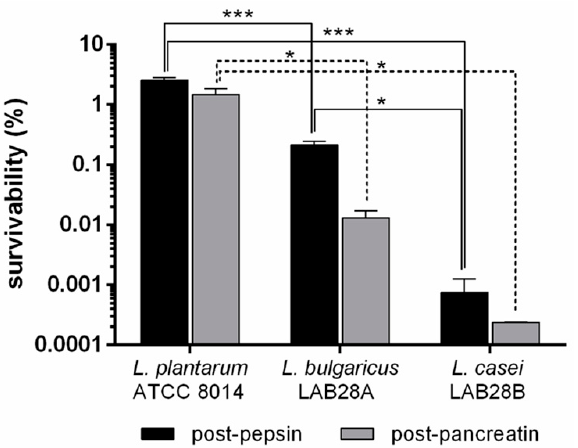
Figure 3. Bacterial survivability to digestion process. Survivability, expressed as percentage with respect to initial cell concentration, of three lactic acid bacteria to in vitro digestion after treatment with pepsin alone (post-pepsin) and with pepsin followed by pancreatin (post-pancreatin). Calculations are based on CFU counts. *** highly significant differences ( p < 0.001); * significant differences ( p < 0.05).